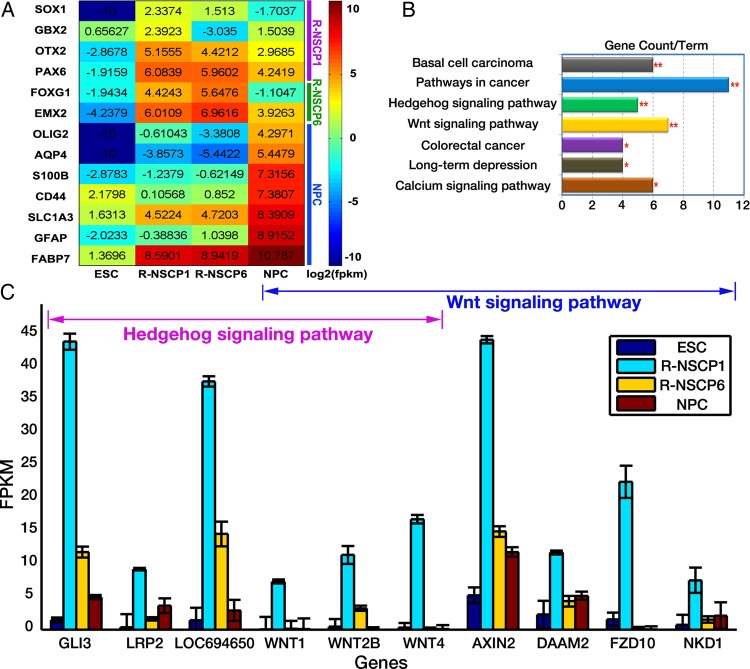
The expression patterns of prevalent genes during rESC neural differentiation. (A) Heatmap plot of expression profile of marker genes of NSCs during rESC neural differentiation. There are three groups for the marker genes, including R-NSCP1-prevalent (purple), R-NSCP6-prevalent (green), and NPC-prevalent (blue). (B) Significantly enriched GO terms associated with prevalent genes of R-NSCP1 stage. Marks * and ** represent the terms satisfy FDR <0.01 in Fisher's exact test with FDR adjustment.33 (C) Gene expression patterns of the Hedgehog and Wnt signalling pathway in rESC neural differentiation. The red arrow includes differentially expressed genes in the Hedgehog pathway, while the blue arrow represents the differentially expressed genes in the Wnt signalling pathway.